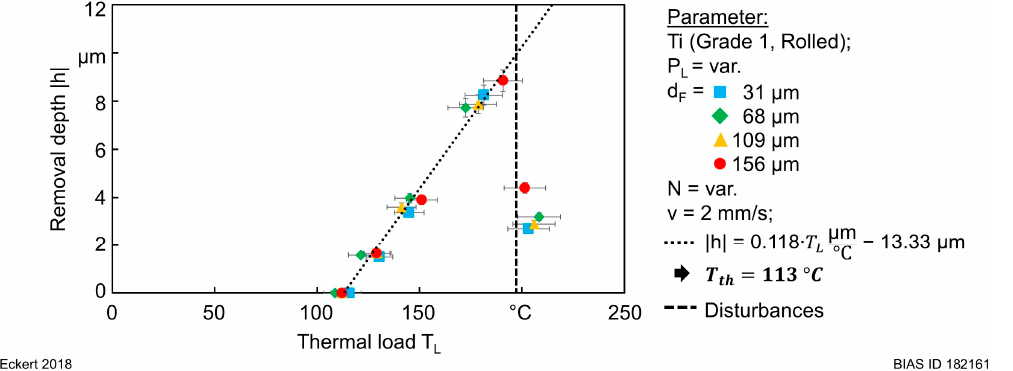
Figure 12. Removal depth over the thermal load T L for different focus diameters.